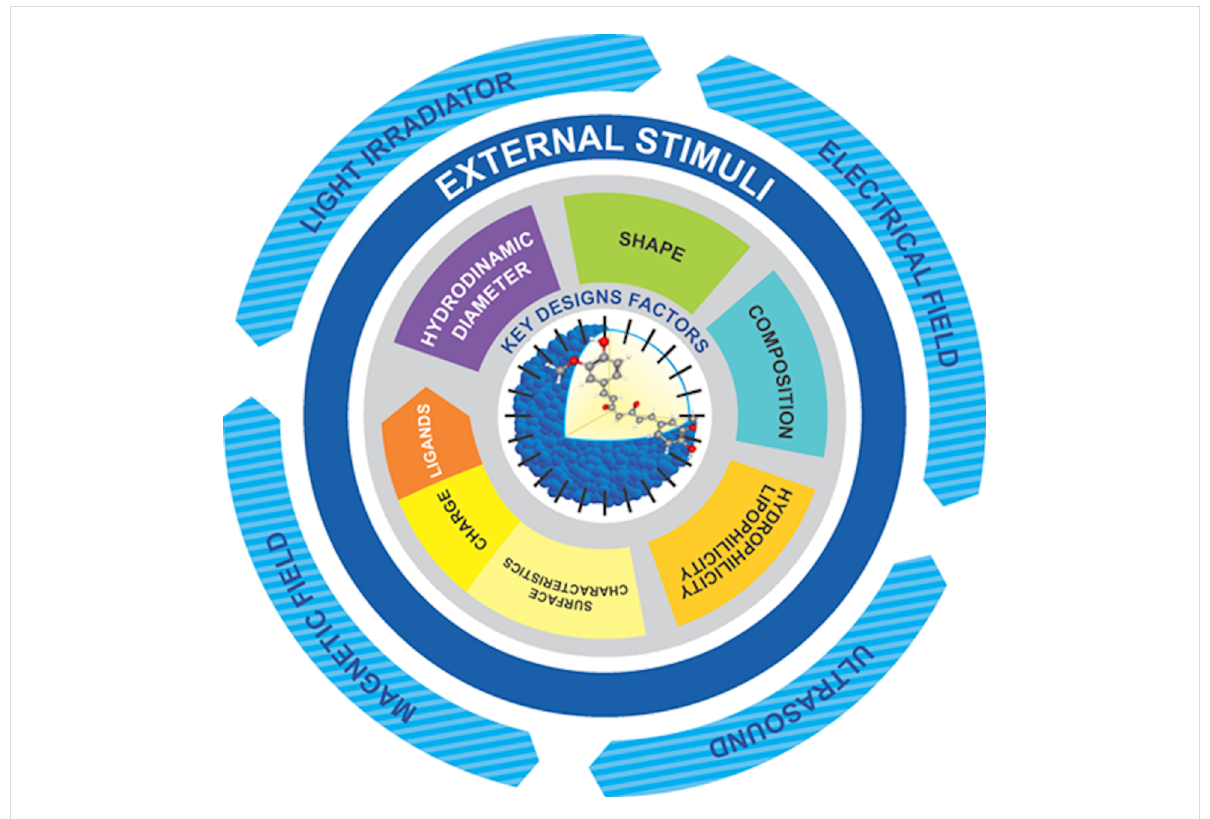
Figure 3: Key factors for the design of nanosystems for targeted cancer therapy.